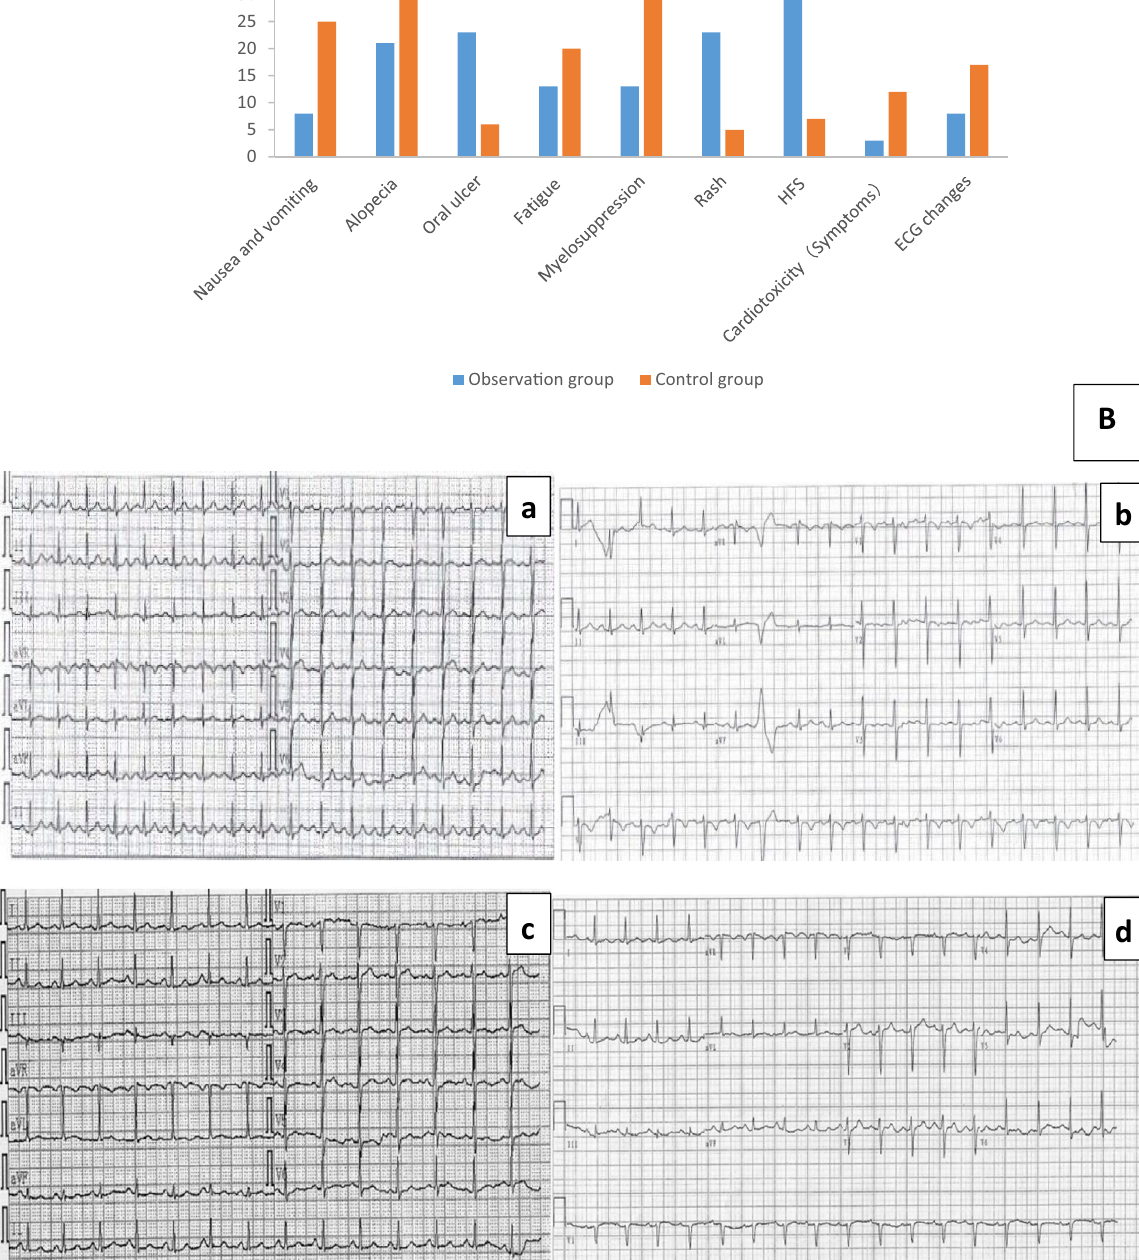
Figure 2. ( A ) The comparison of adverse reactions between observation group and control group; ( B ) ECG comparison. (a) The normal ECG of one patient in the control group before chemotherapy, (b) there was occasional ventricular contraction after chemotherapy; (c,d) were the normal ECG of one patient in the observation group before and after